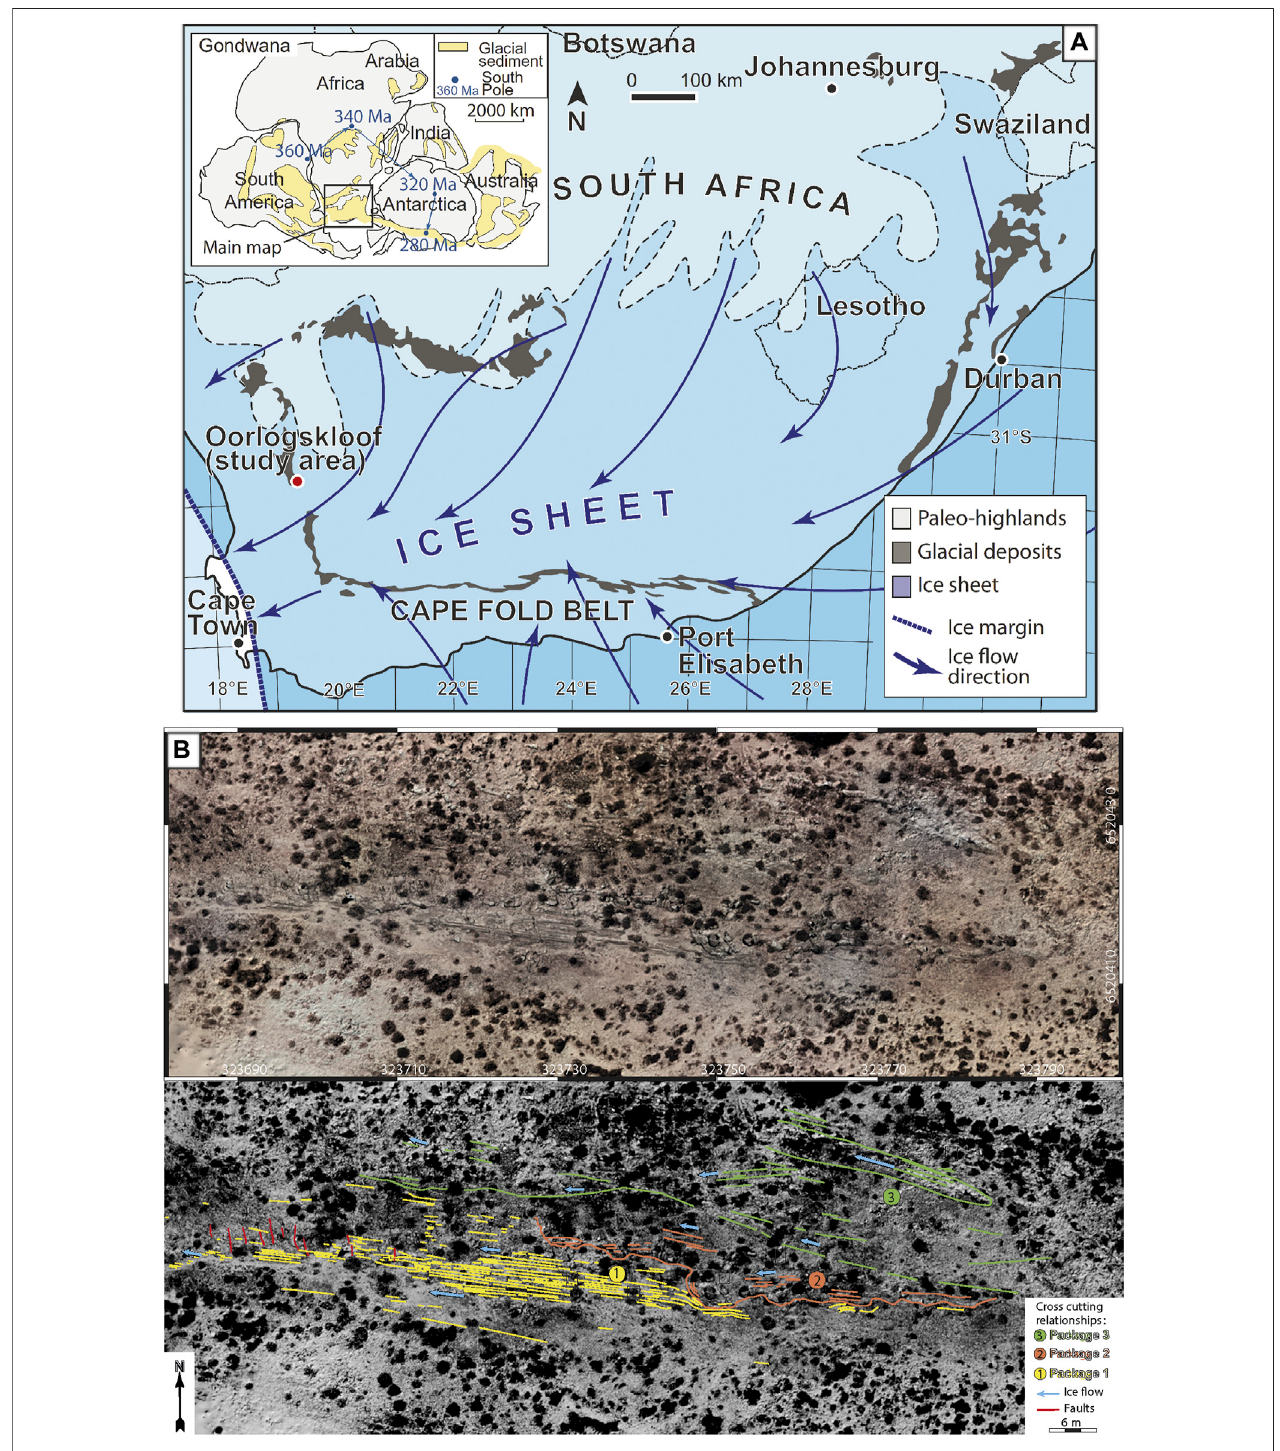
FIGURE 5 | (A) Paleogeographic map of South Africa during the late Paleozoic ice age, and outline of ice-sheet fl ow character, based on Visser (1997), Lopez- GamundiandBuatois(2010).StudyareaatOorlogskloofissituatedatthewesternmarginoftheKarooBasin. (B) Bird ’ seyeviewoftheOorlogskloofglacialpavementof South Africa (top) together with an interpretation of the surface and the recognition of cross-cutting relationships (bottom). The bird ’ s eye view consists of drone data, namely an orthophoto layered over a digital elevation model. From Le Heron et al. (2019b).